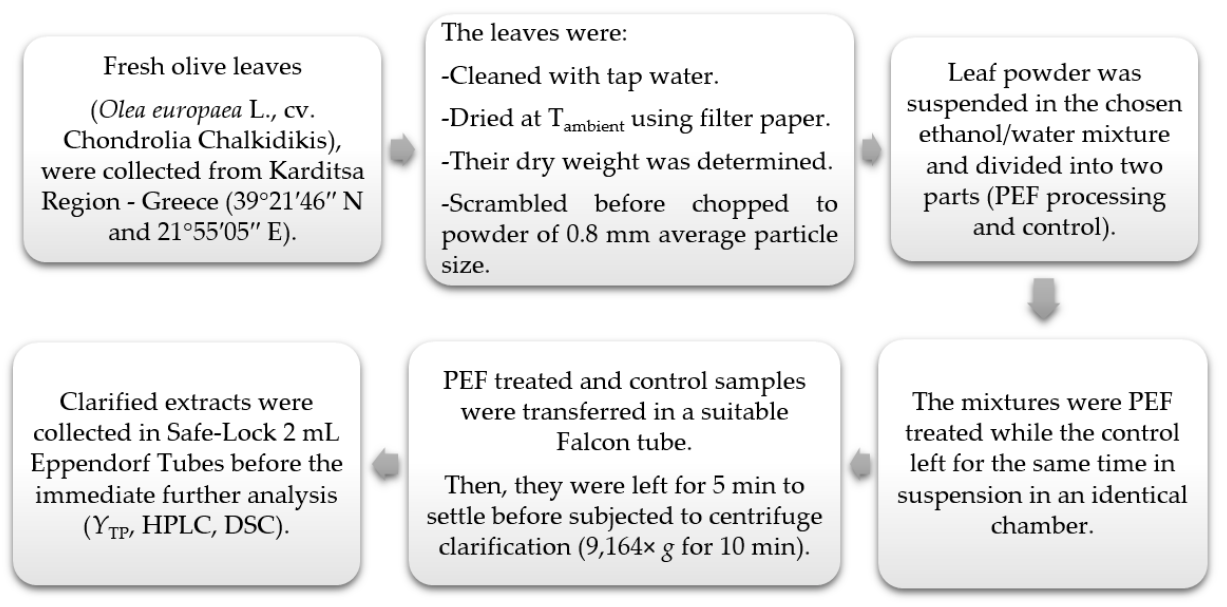
Figure 1. Plant material processing steps. Abbreviations: PEF (Pulsed Electric Field); Y TP (Total Polyphenol Content); HPLC (High Performance Liquid Chromatography); DSC (Differential Scanning Calorimetry).